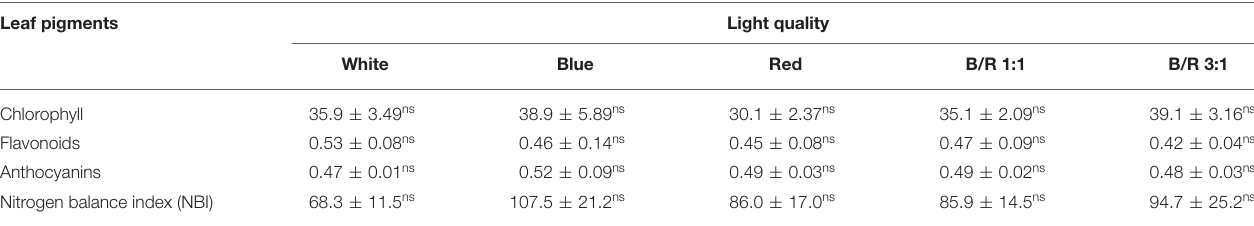
TABLE 4 | Chlorophyll, flavonoid, and anthocyanin content and nitrogen balance index (NBI) of Brosimum gaudichaudii seedlings grown in vitro under different LED spectra for 50 days. Leaf